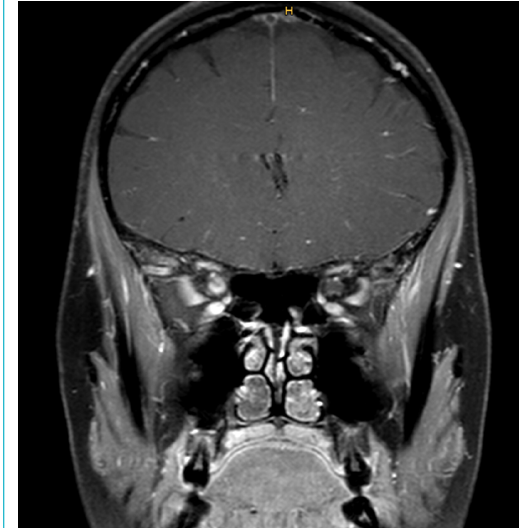
Figure 4: Coronal T1-weighted magnetic resonance imaging scan of the brain showing contrast-media enhancement of the right optic nerve (arrow) in a 43-year-old woman who presented with progres- sive vision loss on the right. Meningioma was expected; however